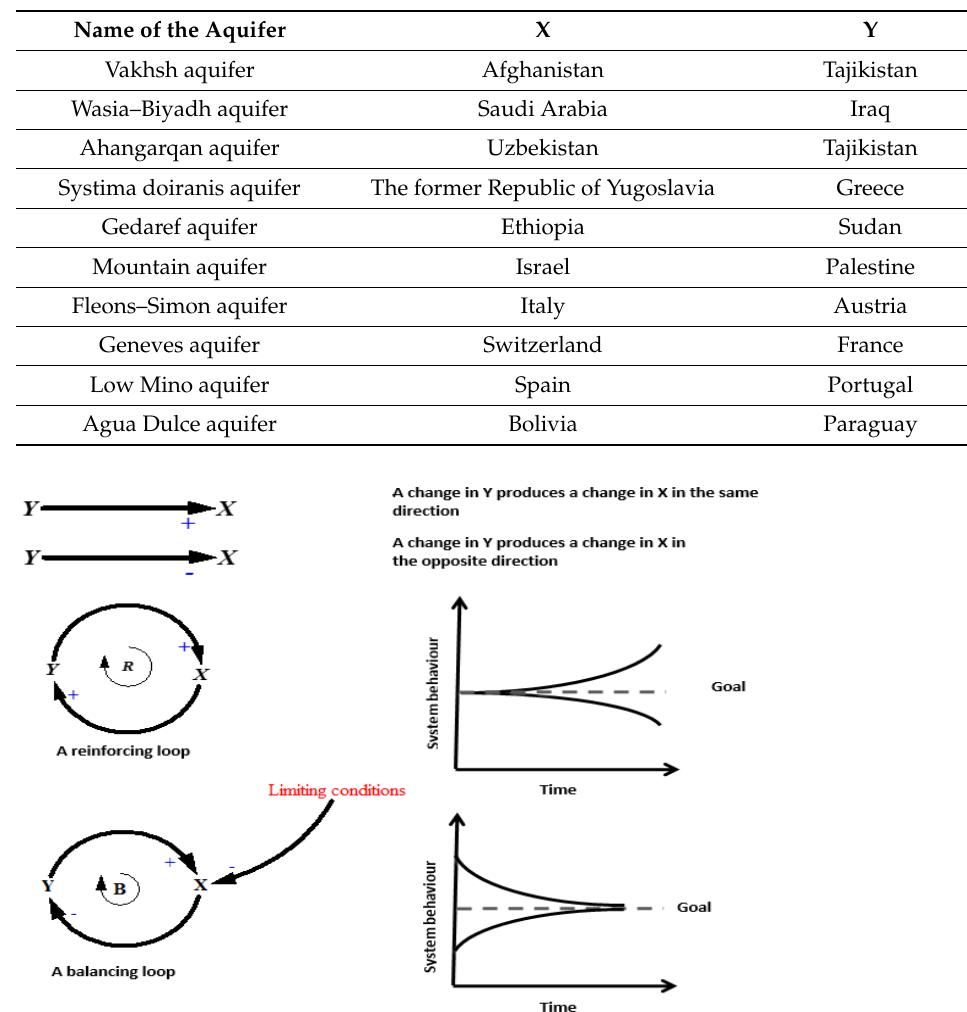
Table A5. Objective cases that can environmentally embrace HSA5.